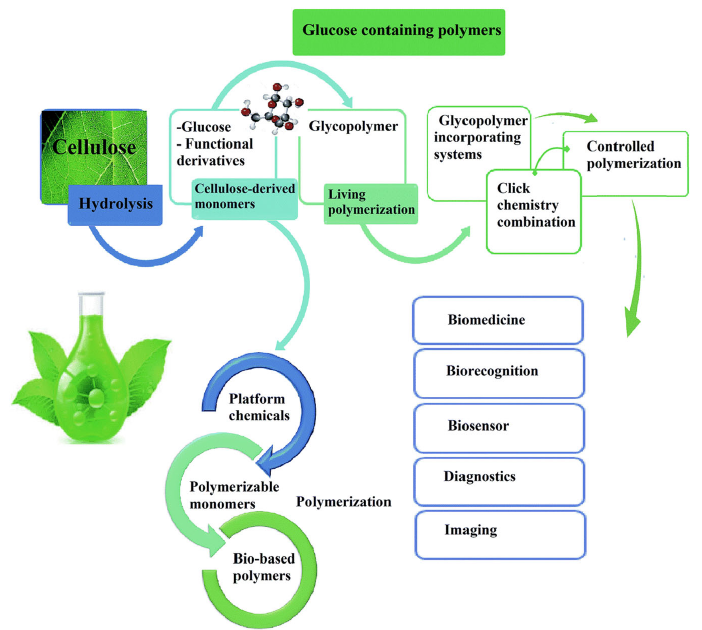
Figure 2. Examples of possible applications of monomers of cellulose for polymer production (reproduced with copyright permission from Shaghaleh et al. [54]). Hydroplastic polymers obtained from cellulose are highly hydrophilic and possess